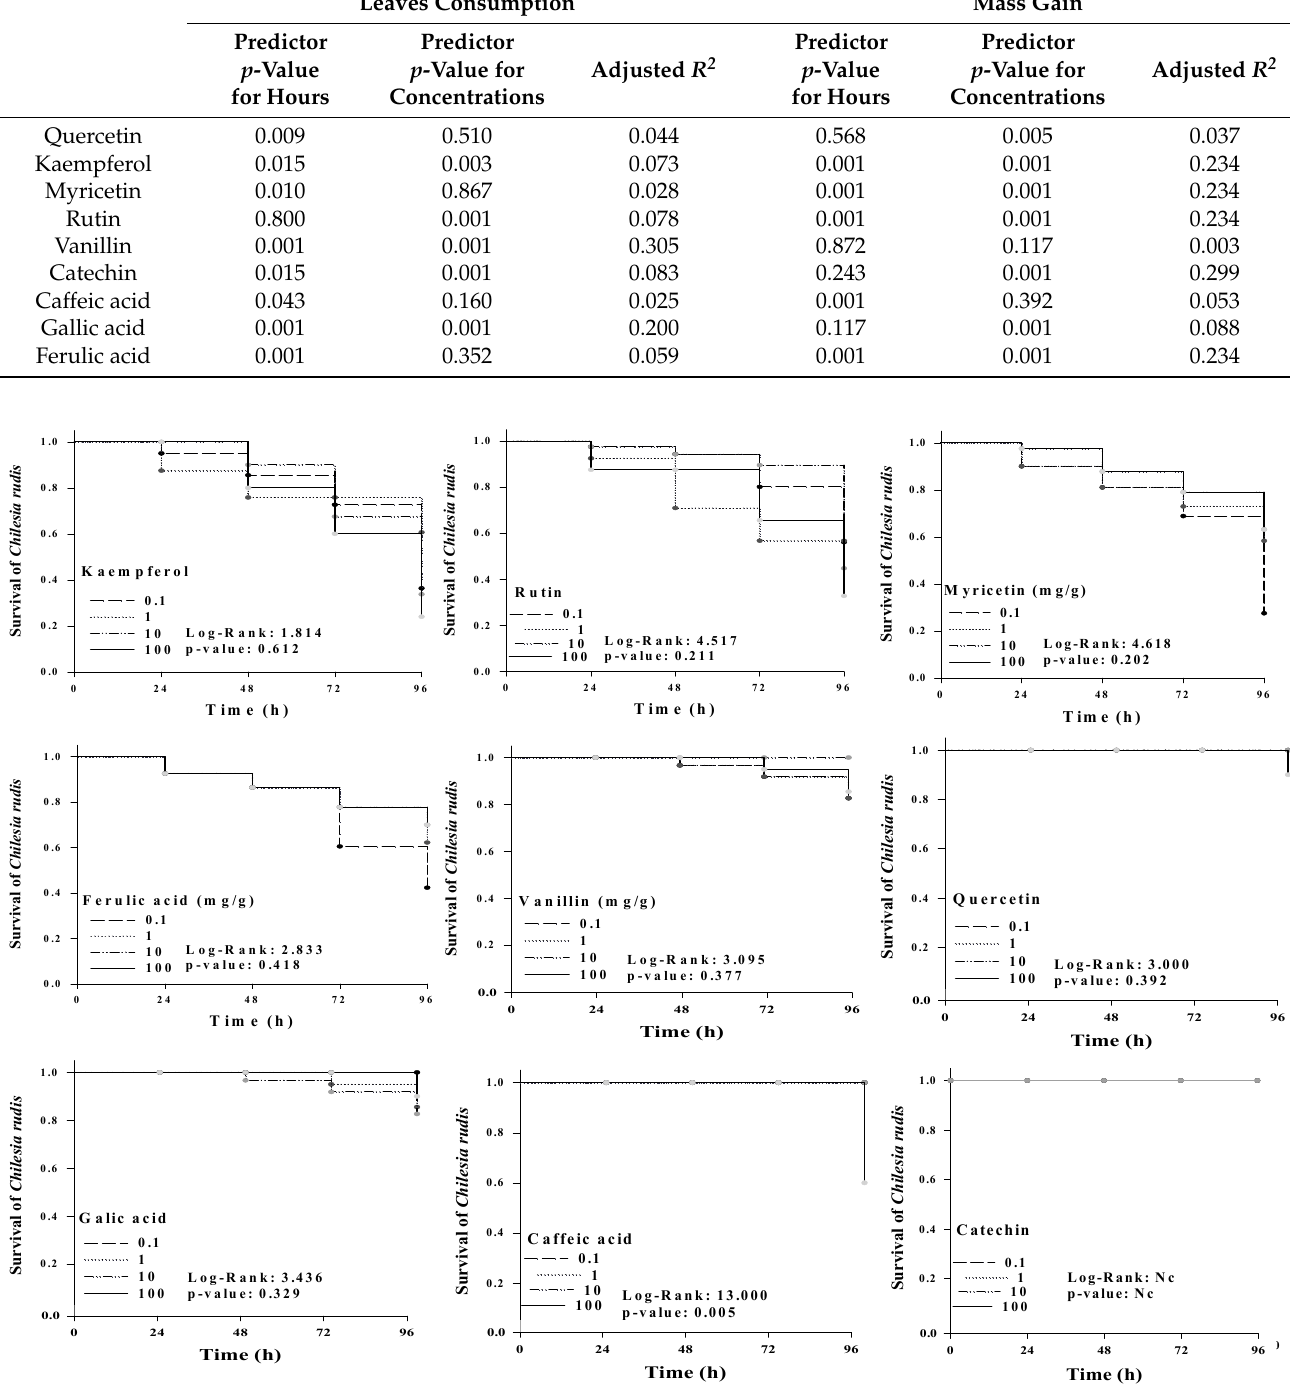
Figure 2. Kaplan-Meier survival curves of C. rudis in relation to compounds, concentration, and time according to log-rank analysis ( p ≤ 0.05).